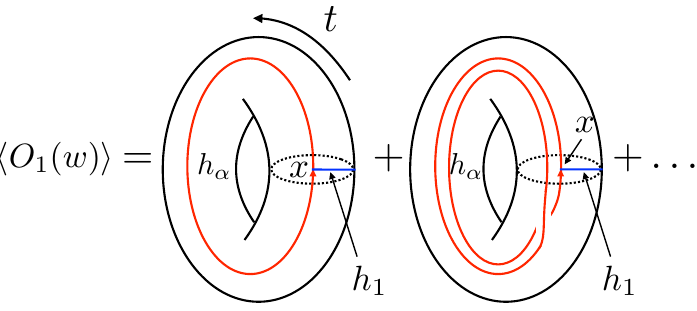
Figure 3 . Bulk dual of the torus one-point function as a sum over bulk diagrams. The blue line represents the bulk-to-boundary propagator G ( h 1 ) ( x ). In the (cid:12)rst diagram, the red line winding b@ around the thermal circle once represents the G ( h (cid:11) ) ( x; q ) contribution, while in the second diagram, 1 the red line winding around the thermal circle twice represents the contribution from two windings around the thermal circle. The bulk point x is to be integrated over all thermal